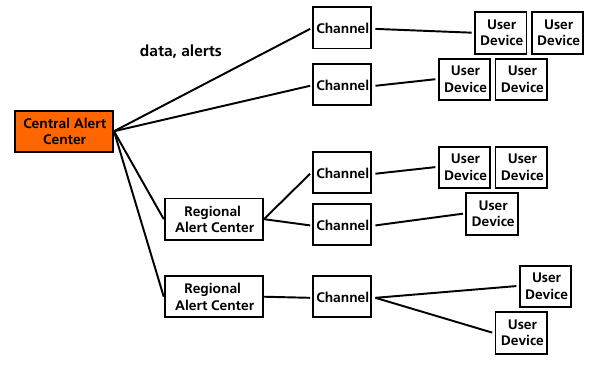
Fig. 3. Divergent section of a warning system. Warnings are deliv- ered to individuals via multiple and diverse channels to maximize the number of successfully warned